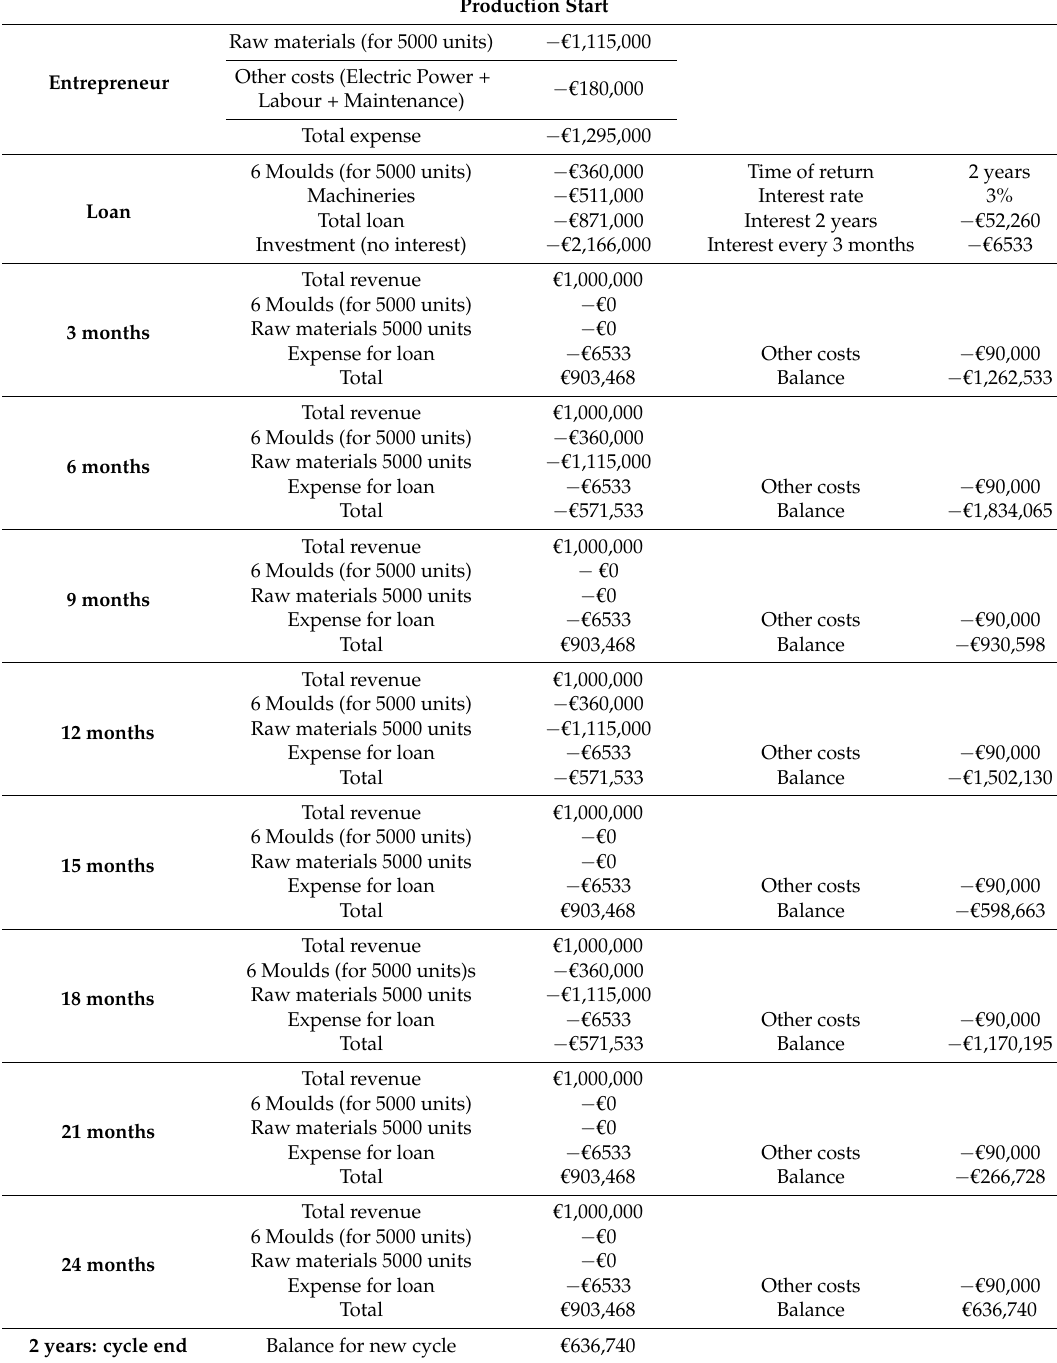
Table 5. Industrial investment and profit outline for the production of 20,000 stack units considering 2500 units sold every 3 months at a price of € 400 per